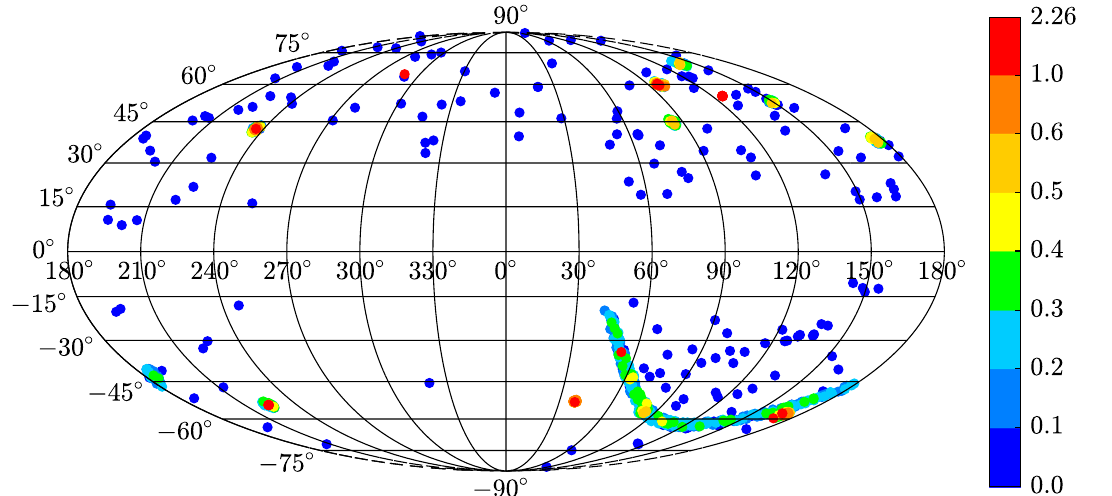
Fig. 1 The distribution of 1048 Pantheon SNIa in the galactic coordinate system, while the pseudo-colors indicate the redshifts of these SNIa. See the text and [94] for